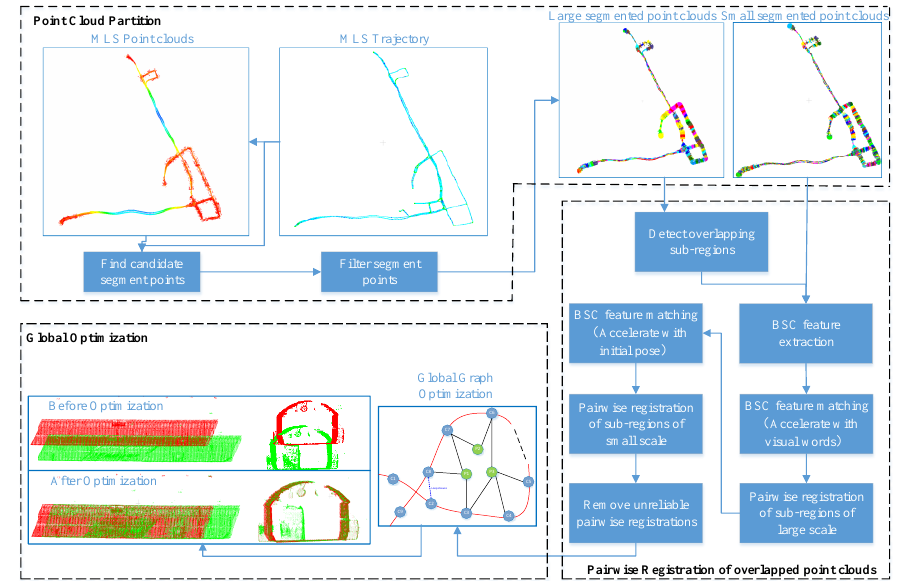
Figure 2. The workflow of the proposed method.